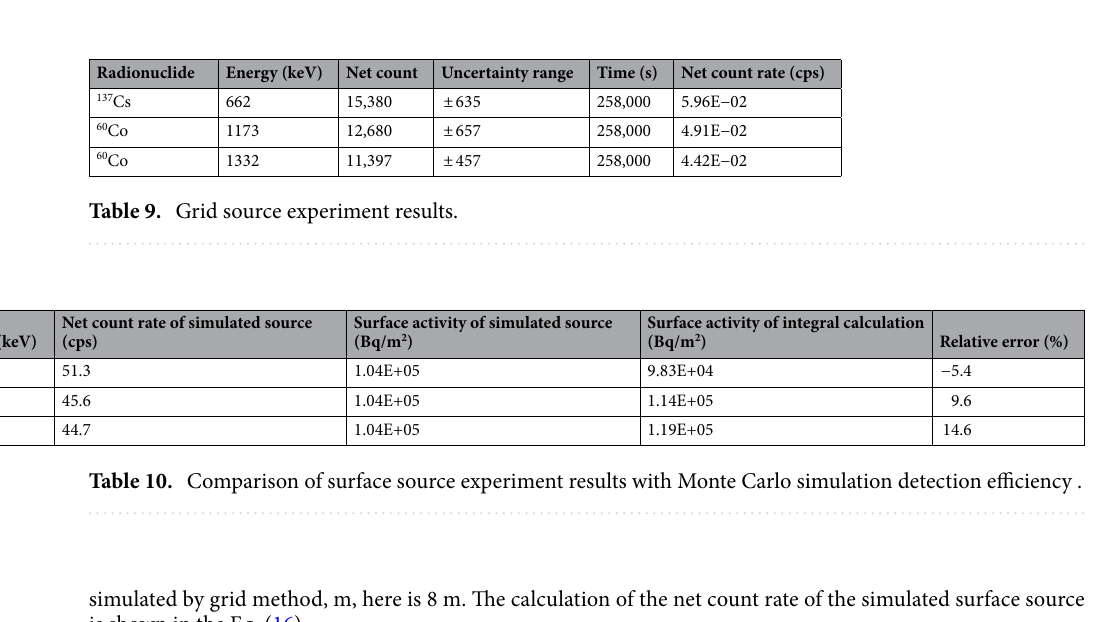
Figure 8. Energy spectrum of a uniformly distributed surface source experiment using the grid method.